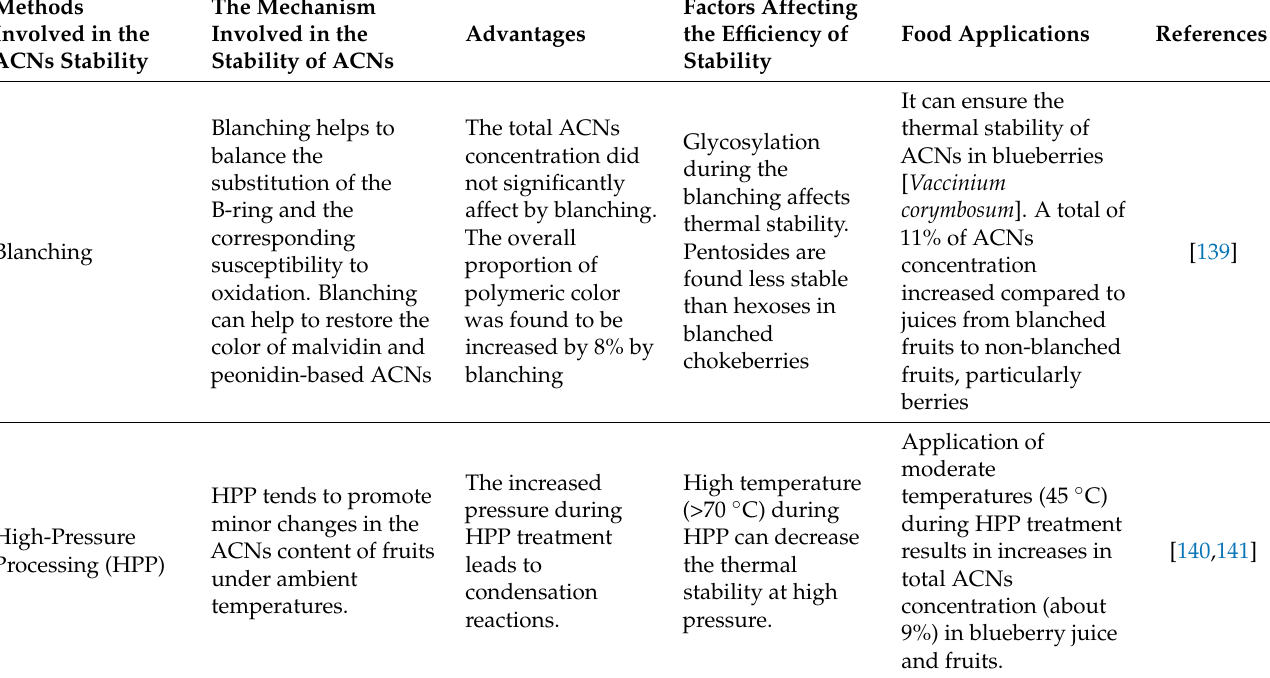
Table 2. Summary of the methods involved in the stability of the ACNs-coloring